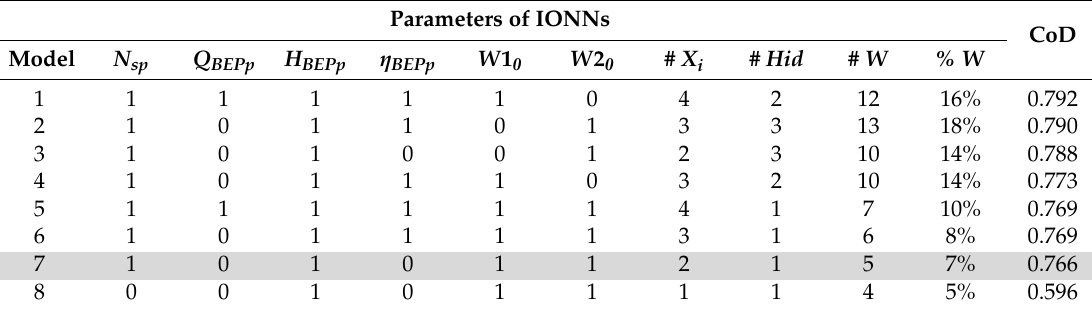
Table 4. Pareto front (min(neurons, inputs, 1 − CoD)) of IONNs for H BEPt . Parameters of